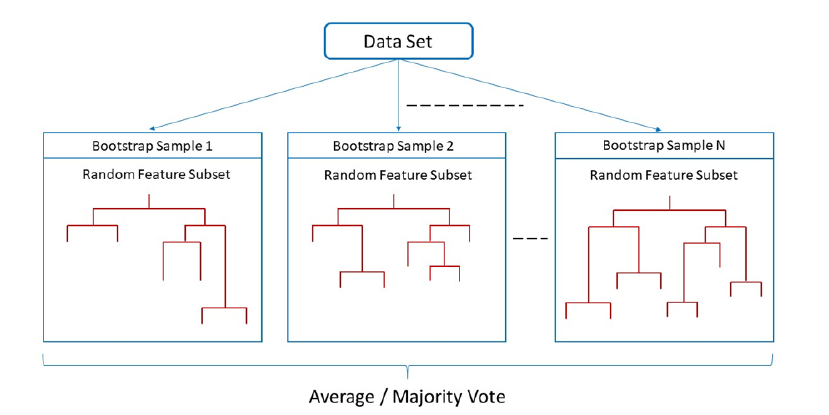
Figure 1. Description of Random Forests model where, each of the branches from sample dataset correspond to a bootstrap sample and a random feature subset is chosen for each branch to construct a decision